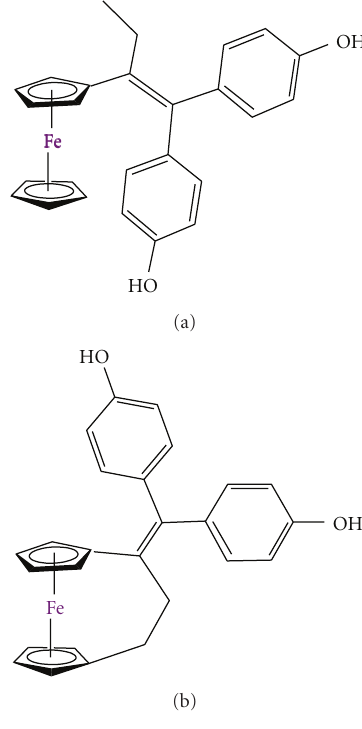
Figure 9: Ferrocene derivatives used in preclinical trials: (a) hydroxyferrocifens; (b) ferrocene complex with a [3] ferroceno- phane